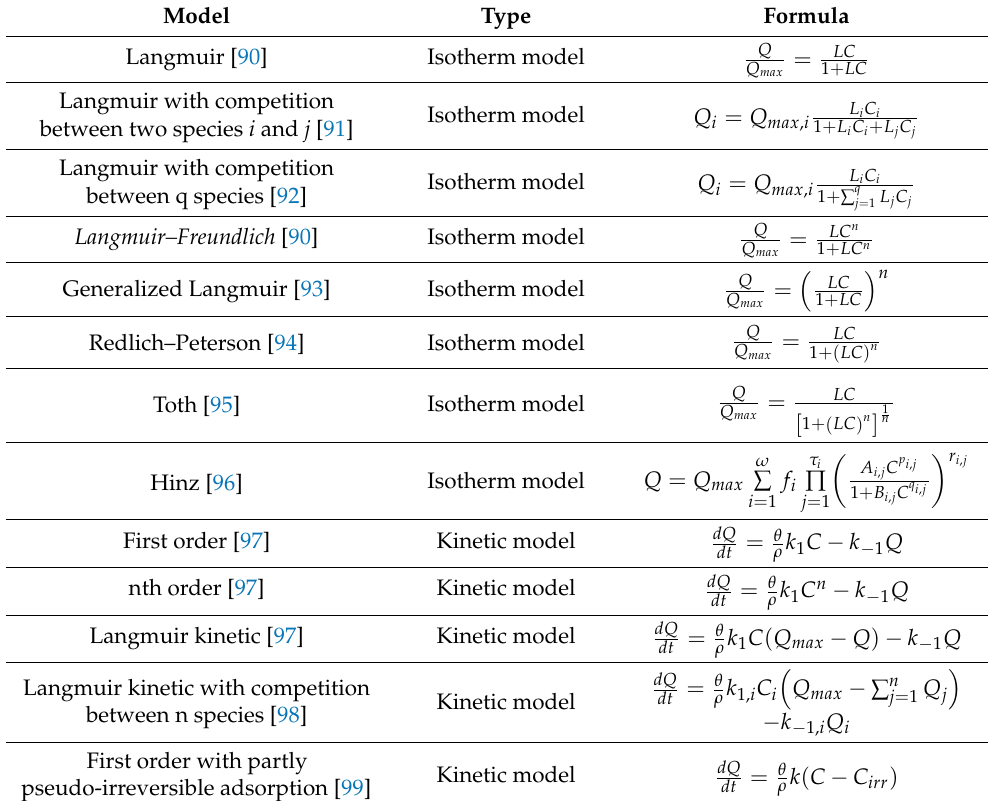
Table 4. Equilibrium isotherms and reaction kinetics